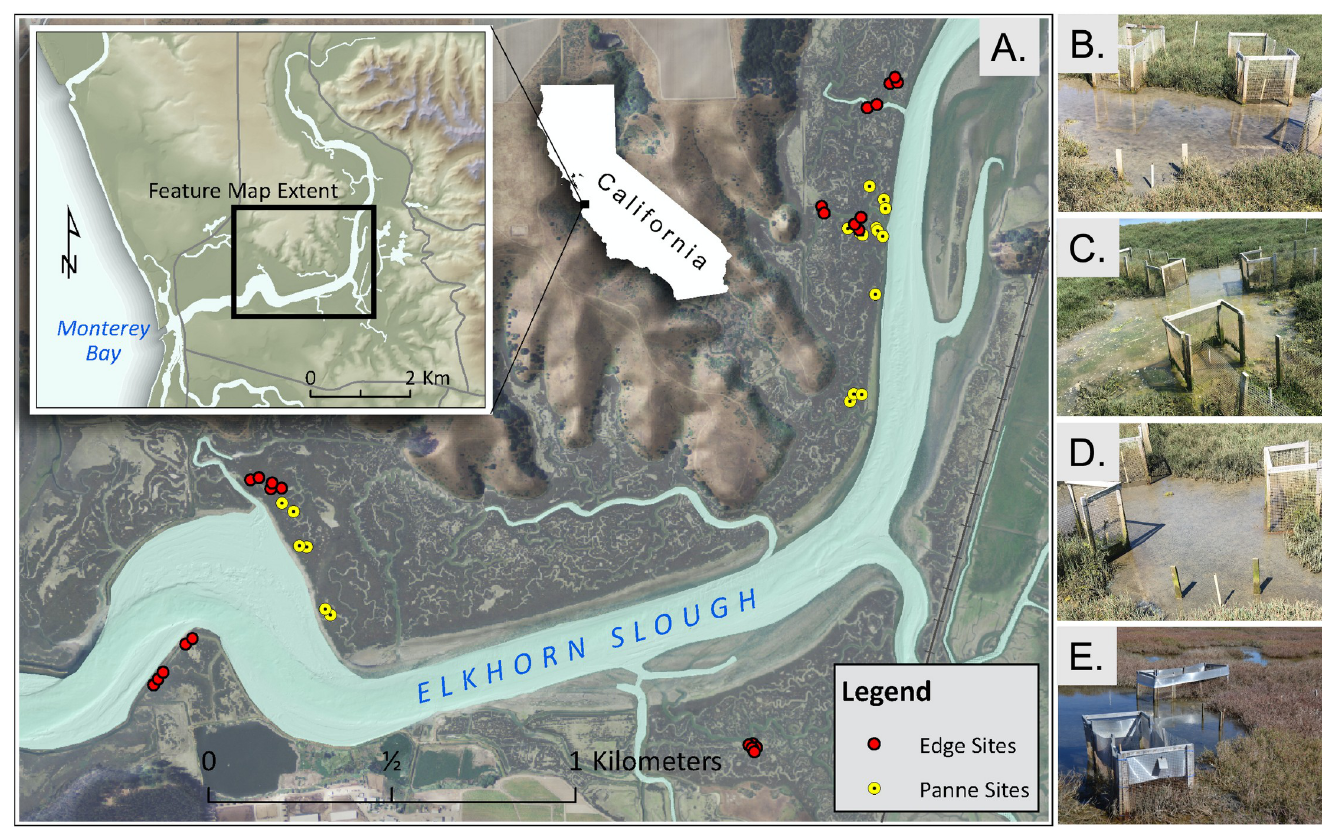
Fig 1. Study design from the landscape to plot scale. (A) Study map showing panne (yellow circles) and creek edge (red circles) studies courtesy of the U.S. Department of Agriculture, Farm Service Agency with topo-enhanced NAIP. Examples of the panne study and variation in panne size, pooling, and drainage, pre (B-D) and post (E) flashing installation (See Supplementary